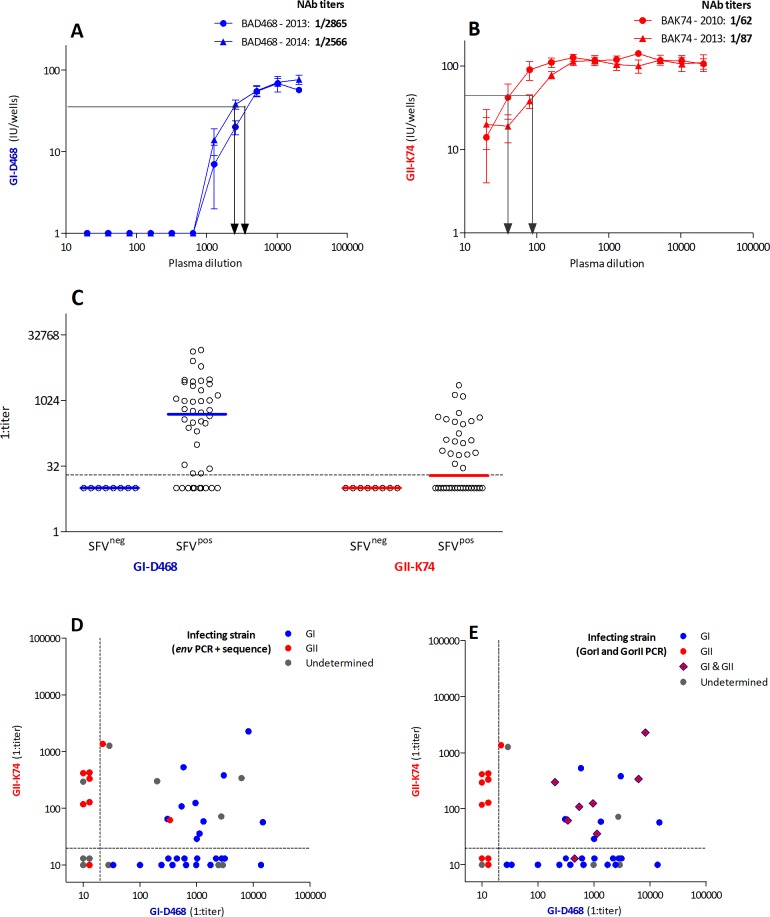
Neutralization of primary gorilla SFV strains by human plasma samples.Neutralization assays were carried out by infecting the GFAB indicator cells with SFV strains previously incubated with serial dilutions of human plasma samples. GI-D468 (A, blue) and GII-K74 (B, red) strains were incubated with autologous samples collected at two time points. The number of infected units per well (mean, SD) is presented as a function of plasma dilution. Arrows indicate neutralization titers. C. GI-D468 and GII-K74 strains were incubated with serial dilutions of plasma samples from 44 people infected with gorilla SFV (SFVpos) and eight uninfected controls (SFVneg). The neutralization titers against both strains are shown and the bars indicate the median values. D and E: The neutralization titers against GI-D468 (x axis) and GII-K74 (y axis) are presented for the SFV-infected individuals, with symbols colored according to their genotype. Panel D shows the genotypes previously obtained by PCR amplification of the env gene followed by sequencing [33]. Panel E shows genotypes defined by GI and GII-specific PCR described in this study. The dashed lines indicate the neutralization detection thresholds (1:20).